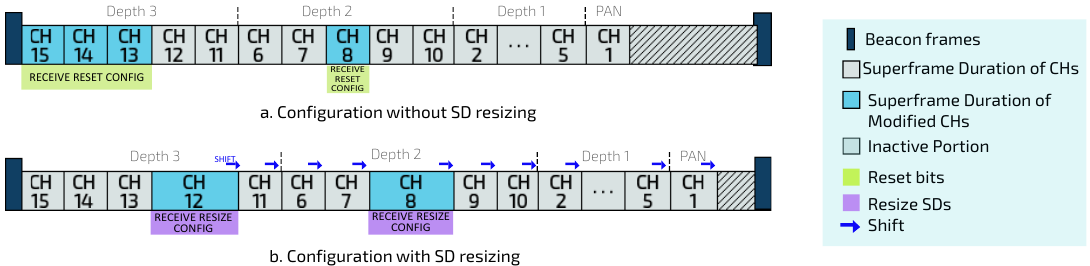
Figure 7. Communication structures after the reconfiguration analysis.